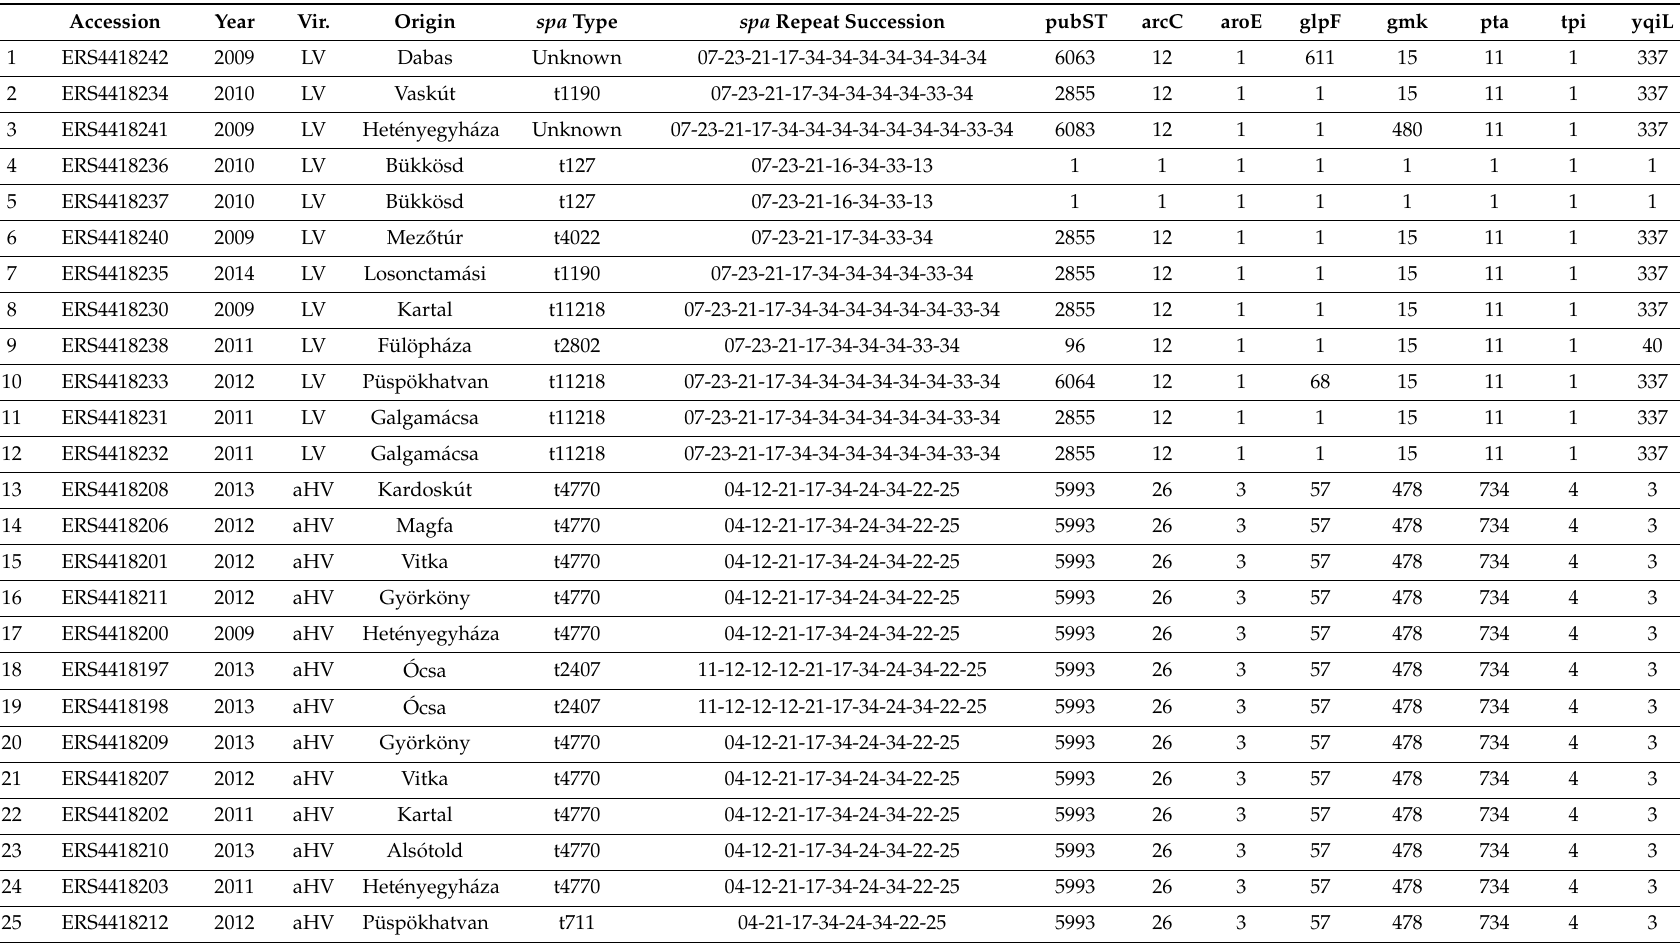
Table 1. Epidemiological and genotypic details of the Staphylococcus aureus isolates of rabbit origin investigated with whole-genome sequencing. Geographic place of origin is provided, where only the country is available, it is in all capital letters. The virulence type is only provided for the strains collected by the authors. Vir.: virulence type determined by multiplex PCR. Year: year of isolation of the